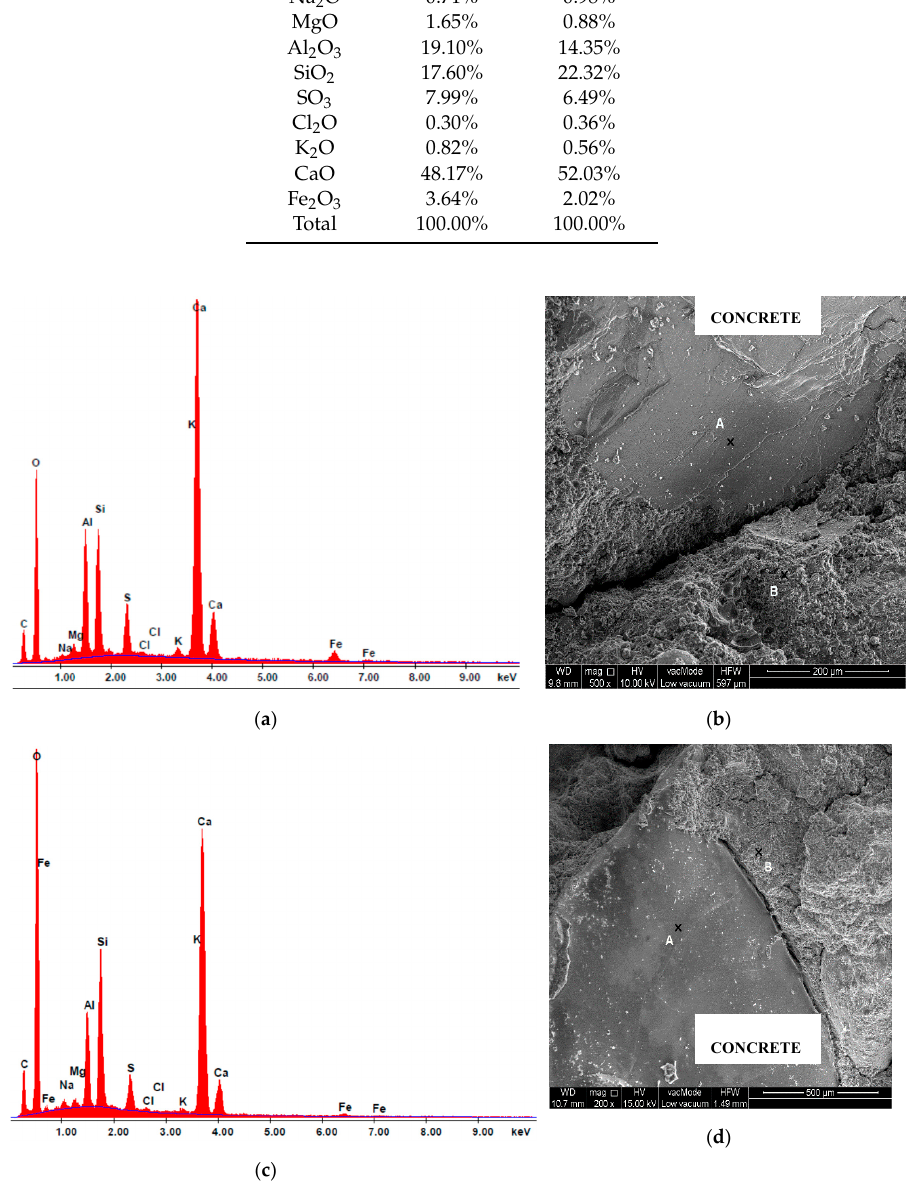
Figure 12. Analysis of the C-7.5 concrete determined from point B: ( a ) chemical composition spectrum of SEM-EDS, 20 °C; ( b ) microstructure, 20 °C; ( c ) chemical composition spectrum of SEM-EDS, 800 °C; ( d ) microstructure, 800 °C.